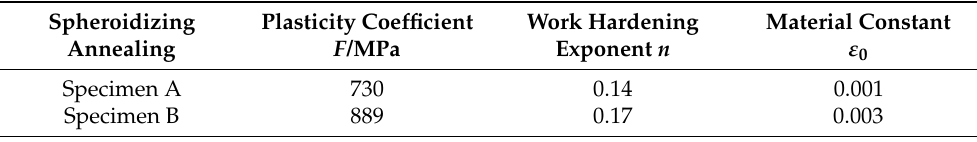
Table 3. Material constants of Swift’s law of SCr420H.